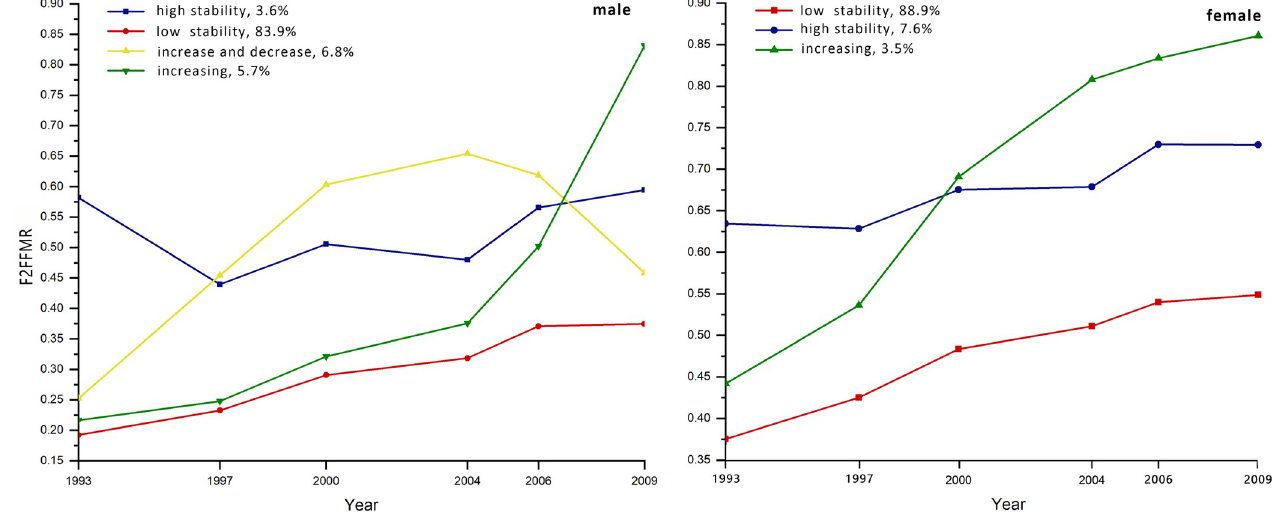
Fig 2. Latent body fat trajectories of each group between 1993 and 2009, identified using group-based trajectory modeling.